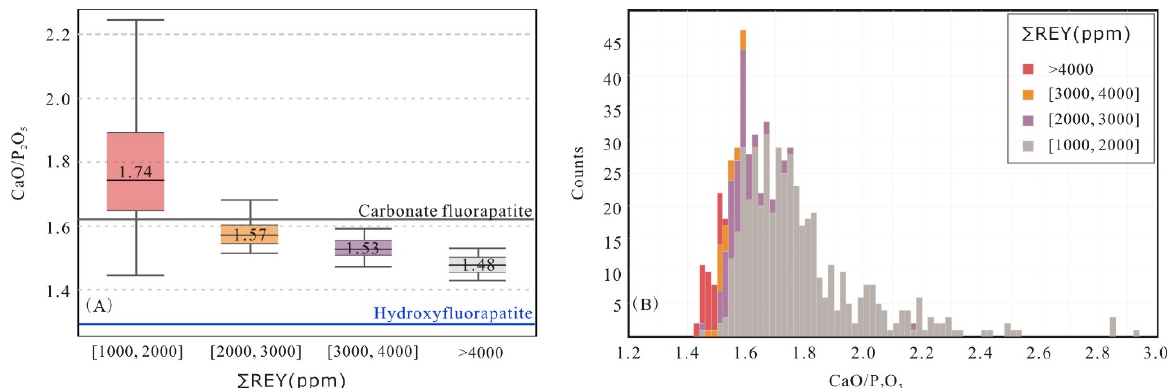
Figure 5. ( A ) CaO/P 2 O 5 box ‐ plot diagram and ( B ) Frequency distribution histogram of sediment samples with different Σ REY enrichment levels. The ranges of ∑ REY are 1000 to 2000 ppm, 2000 to 3000 ppm, 3000 to 4000 ppm, and more than 4000 ppm. The results show that the ratio of CaO/P 2 O 5 is more concentrated when ∑ REY exceeds 2000 ppm. Data sources as in Figure 1.